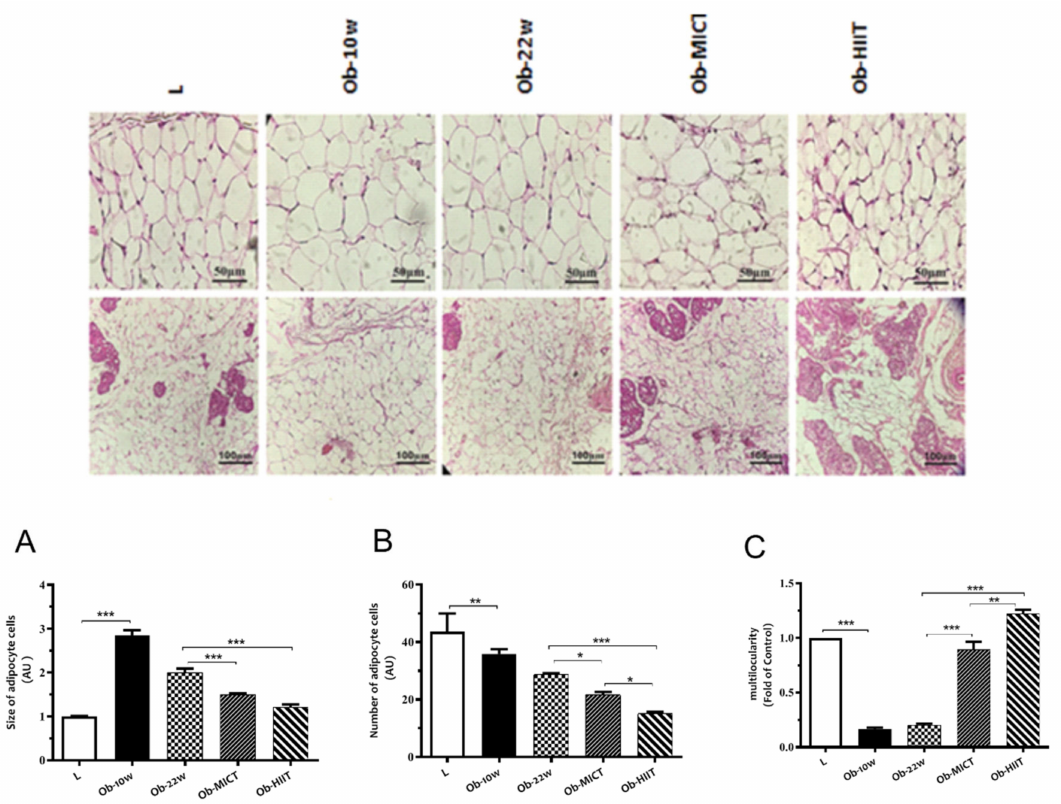
Figure 2. The e ff ect of obesity and exercise training on adipocyte ( A ) size, ( B ) cell number, and ( C ) percentage of mulilocular cells in subcutaneous adipose tissue. Data are represented as means ± SEM ( n = 6) and significant di ff erences between groups indicated by: * p < 0.05, ** p < 0.01, *** p < 0.001. L: lean; Ob-10w: obesity-10 weeks; Ob-22w: obesity + sedentary; Ob-MICT: obesity + moderate-intensity continuous training; Ob-HIIT: obesity + high-intensity interval training